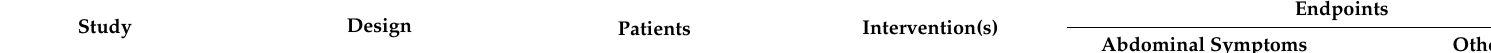
Table 1. Summary of trials evaluating the effect of a low FODMAP diet on gastrointestinal symptoms in